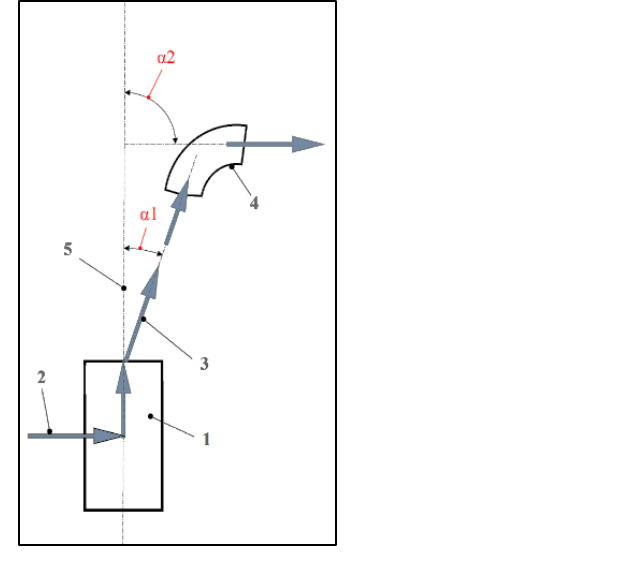
Figure 22. Switchgear diagram – variant No. 5: 1- switchgear; 2- inlet channel; 3- gas jet; 4- piped deflector.